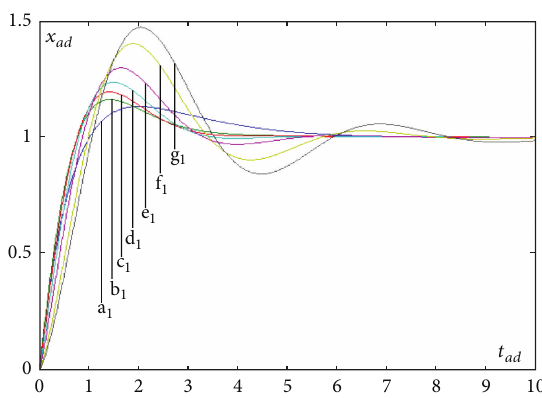
Figure 6: Poles of the closed-loop system in the 𝜎 -plane: details of the stable overdamped, hyperdamped, and ultradamped regions.